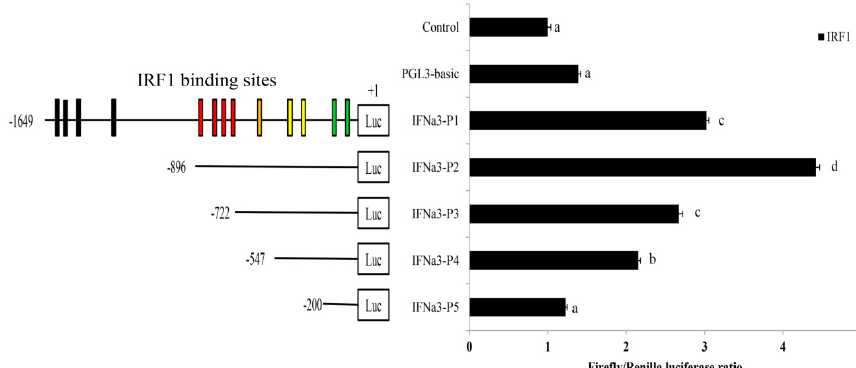
Figure 7. Activation of ToIRF1 in response to rIFNa3. ( A ) GPS cells were cultured in 6-cm culture dishes (2.5 × 10 6 cells/dish) overnight and then treated with rIFNa3 in a range of doses as indicated for 24 h. GPS cell extracts were used to detect IRF1 proteins by Western blot analysis. ( B ) The corresponding ratio of gray values of ToIRF1 and GAPDH proteins. All values are presented as the means ± SD ( n = 3). Bars on the same group with different letters are significantly different from one another ( p < 0.05).